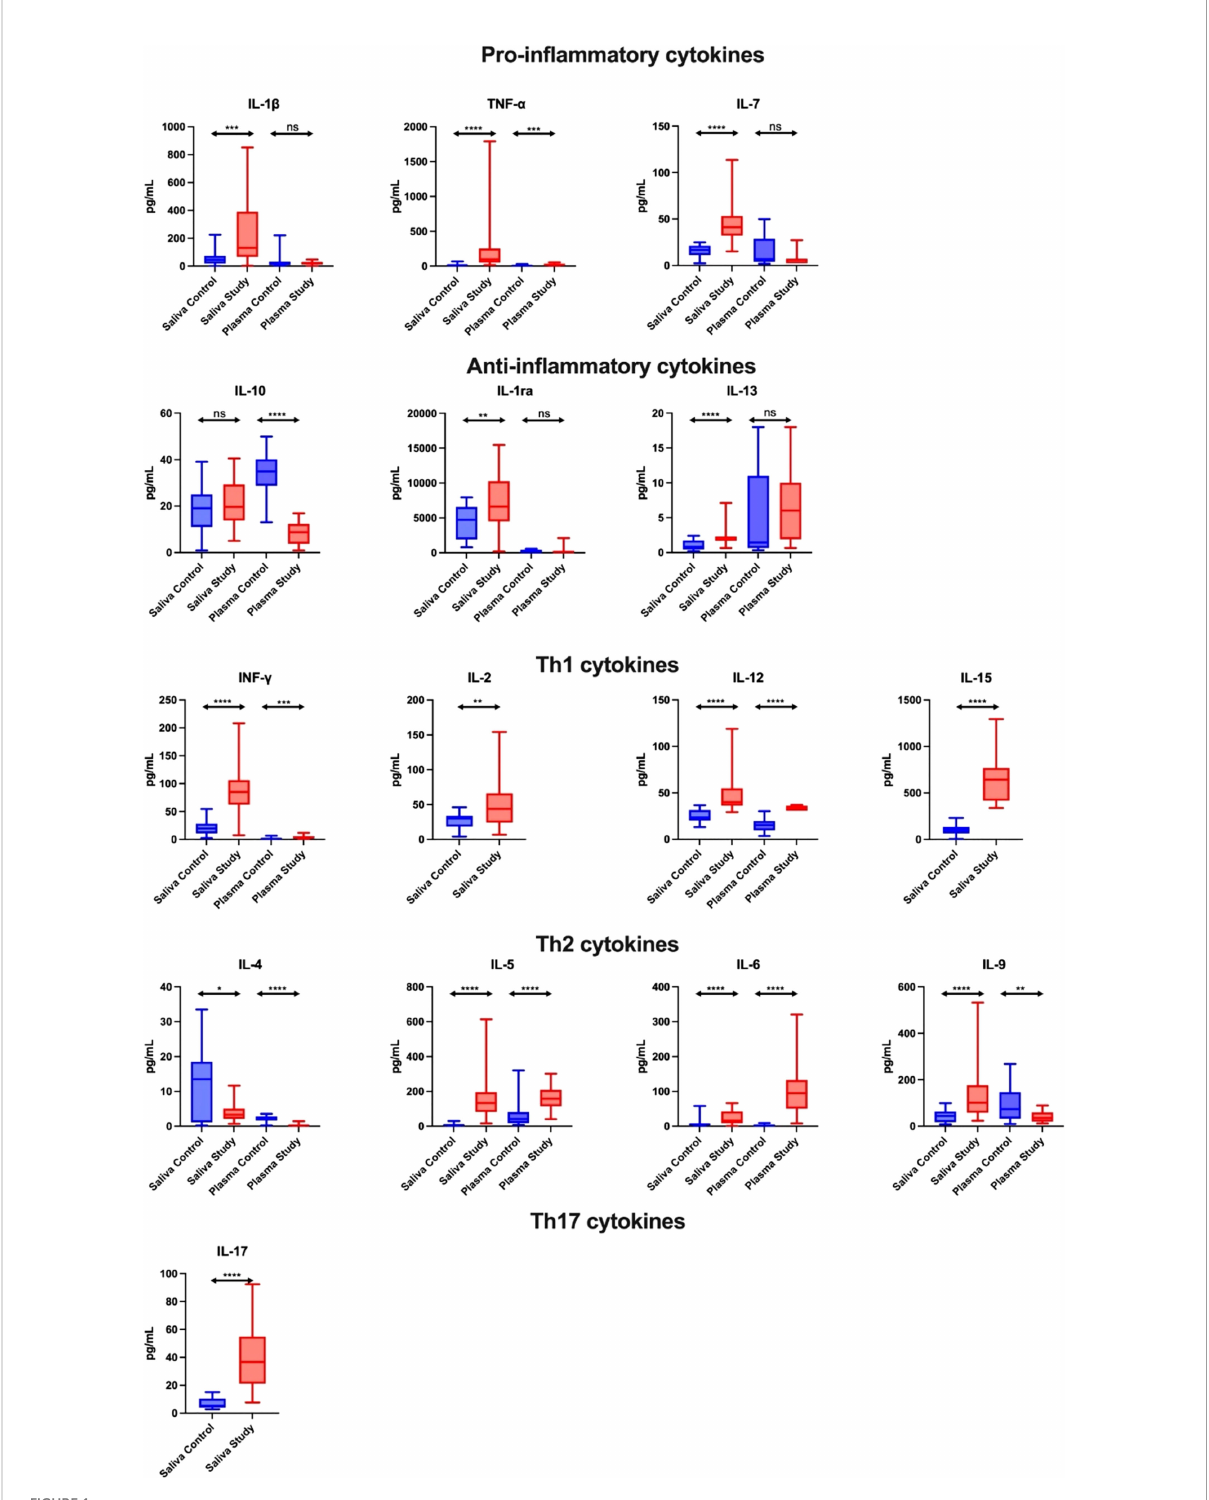
FIGURE 1 Salivary pro-in fl ammatory and anti-in fl ammatory pro fi le in patients with heart failure (n = 30) compared to the control (n = 30). The results are presented in box-and-whisker plots as median (minimum-maximum). For comparisons between the two groups, the Whitney U-Mann test was used. *p< 0.05, **p< 0.01, ***p< 0.001, and ****p< 0.0001. NS, non signi fi